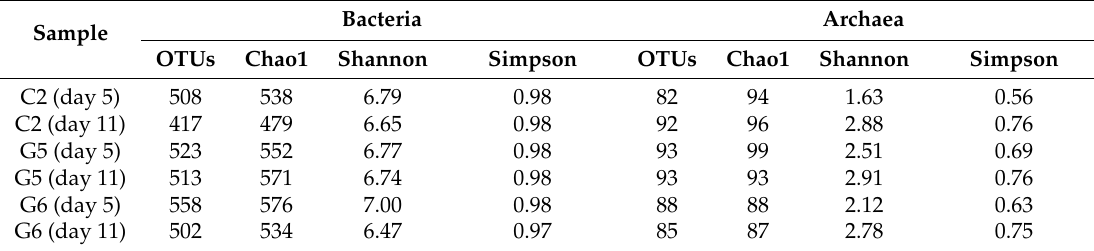
Table 2. Alpha diversity of microbial communities.